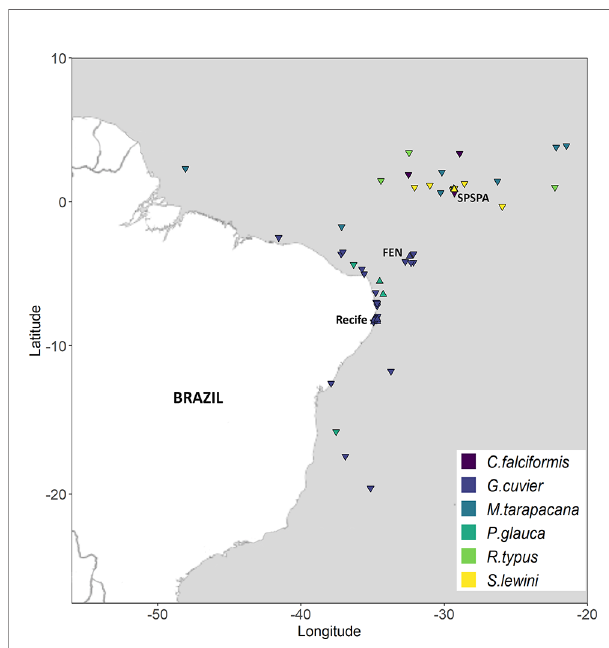
FIGURE 1 | Map of the study area in the western equatorial and tropical South Atlantic Ocean depicting tag deployment locations (triangles) and pop- up locations (inverted triangles). Colors represent different elasmobranch